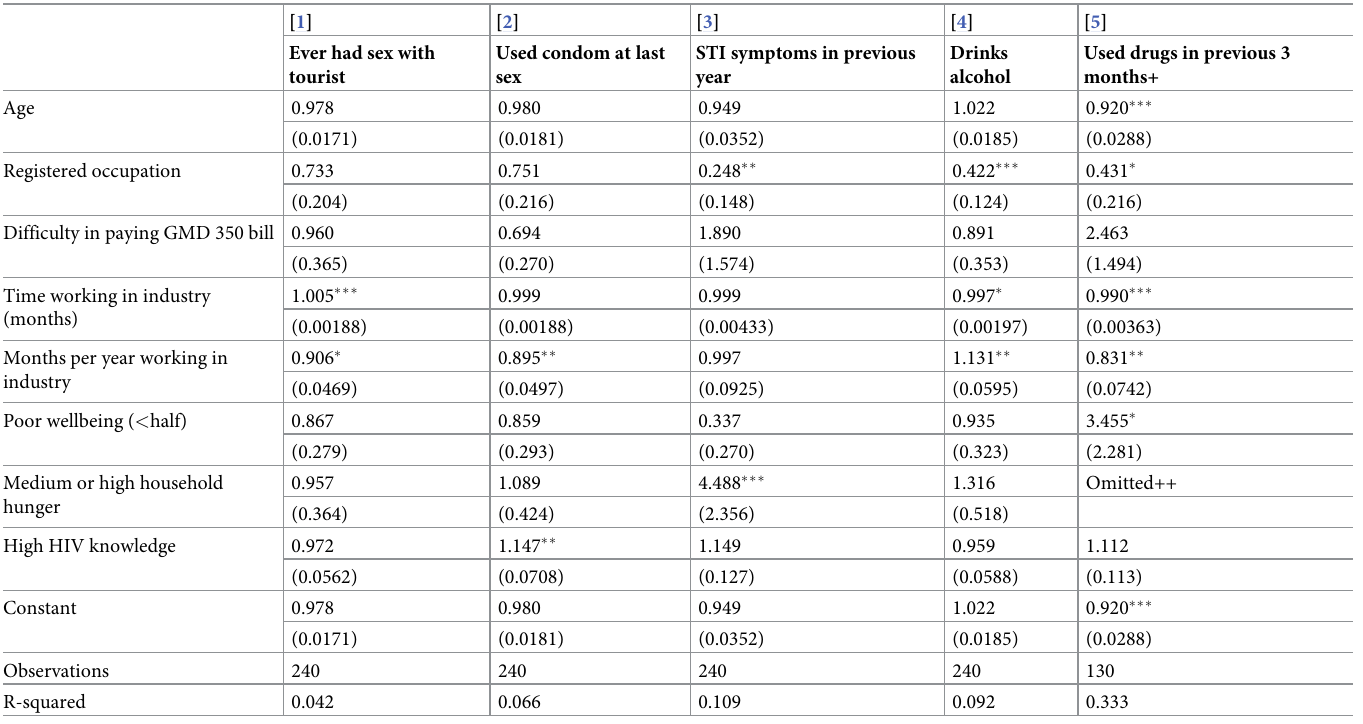
Table 3. Correlates of risk behaviours: Multivariable logistic regression.